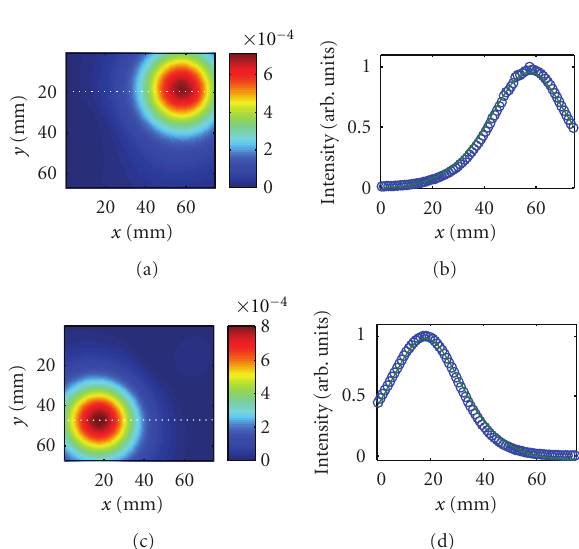
Figure 9: NCIDs on the detector plane are shown in (a) and (c); corresponding Green’s function fits to the horizontal spatial profiles through the dashed line are shown in (b) and